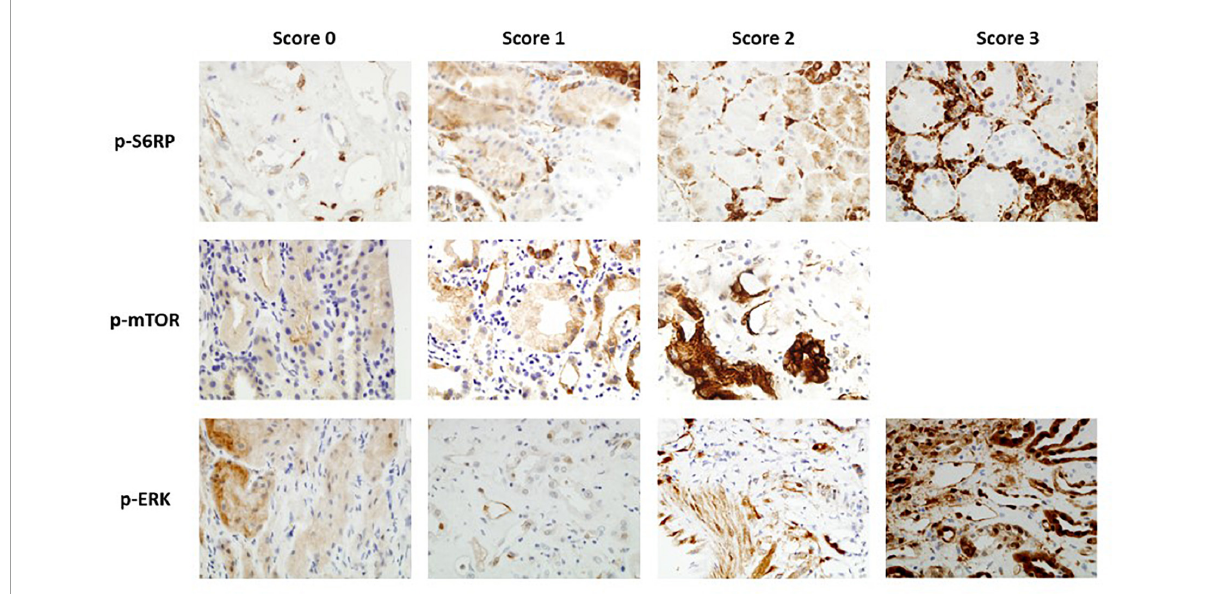
FIGURE1 Immunohistochemistry staining of p-S6RP, p-ERK, and p-mTOR in kidney transplant biopsies (40 × ). Representative images of different staining scores for each protein are shown.